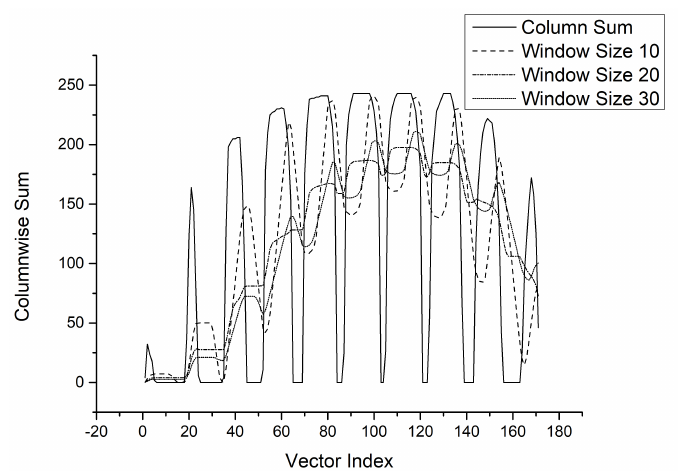
Figure 13. OOK Sliding Window Thresholding.